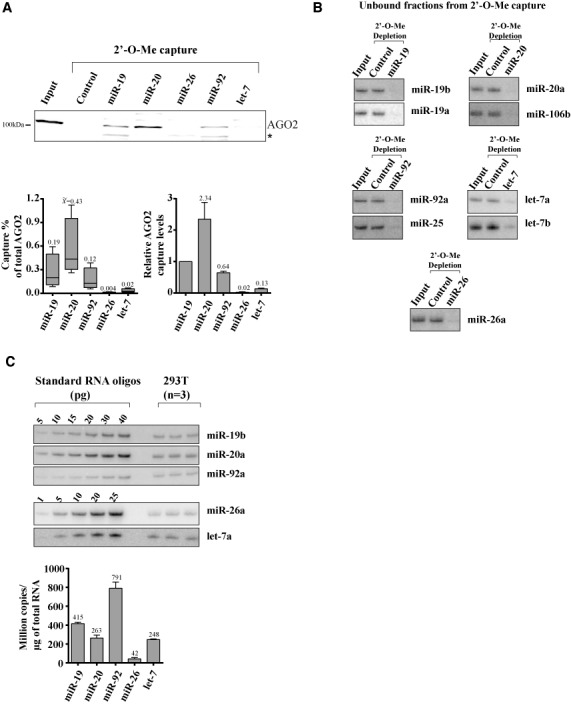
Comparative quantitation of miRNA expression and miRISC capture for the miRNA families considered in this study. (A) miRISC capture was conducted as above, for the miR-19, -20, -92, -26 and let-7 families. Captured AGO2 was quantified from four independent biological replicates (bottom panels). Results are presented as percentage of total AGO2 in HEK 293T lysate input (10 μg) (box plot, bottom left, median values [x with tilde] indicated above) and normalized against miR-19 capture for each individual lysate (bottom right, average values indicated above (B) northern blot analyses of unbound miRNA fractions recovered after miRISC capture. (C) Quantitative northern blot analyses of each miRNA for three independent biological replicates. RNA oligonucleotides were used as standards and copy numbers were calculated per microgram of isolated RNA (bottom, average values indicated above). All other paralogous miRNAs examined were less abundant (Supplemental Materials). The asterisk (*) indicates a non-specific band.